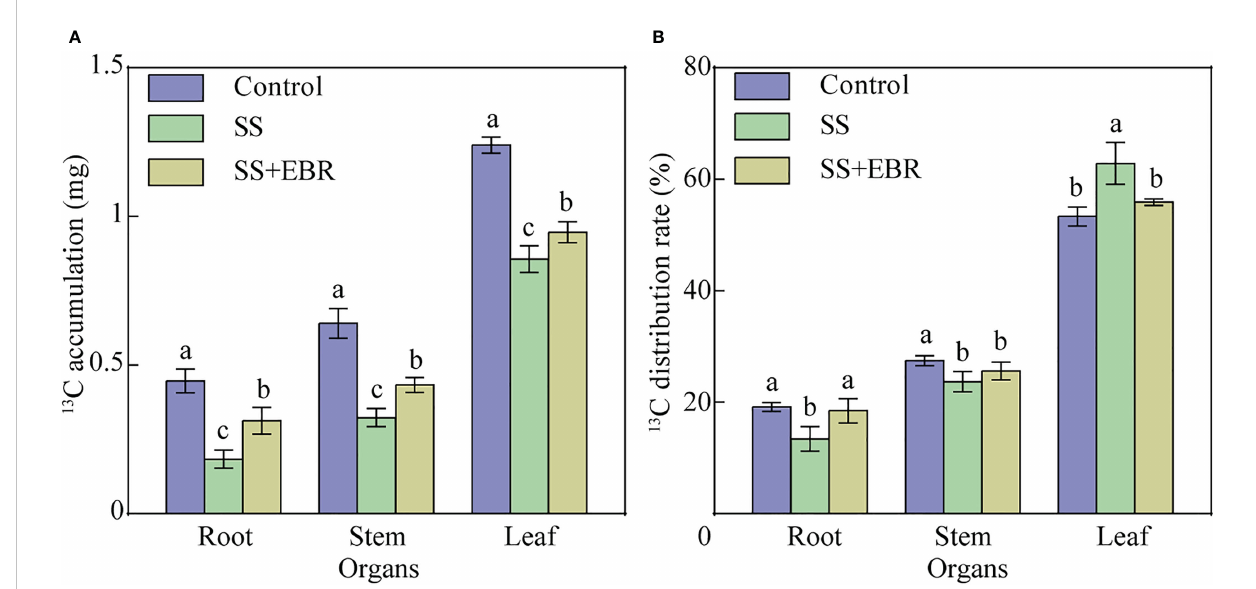
FIGURE 5 13 C accumulation (A) and 13 C distribution (B) under various treatments. The error bars represent the SD, and the different letters indicate signi fi cant differences ( P <